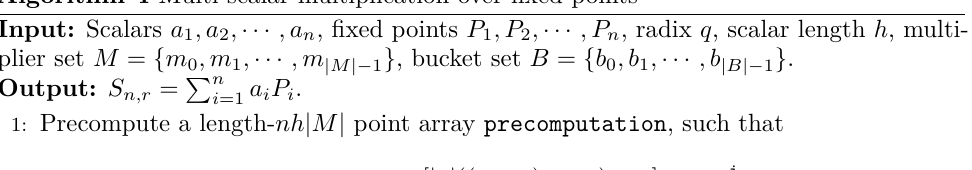
Algorithm 4 Multi-scalar multiplication over fixed